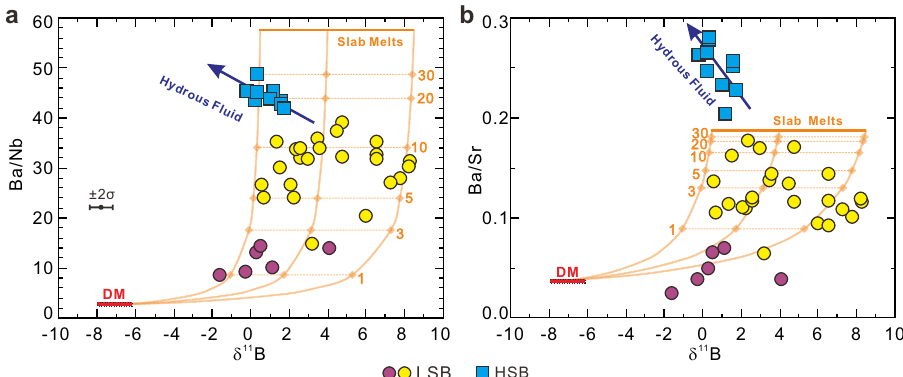
Fig. 5 Boron isotopes and trace element systematics of the Expedition 352 boninites compared to mixing trajectories between the calculated slab melt/ fl uid and the depleted mantle. Plots of a Ba/Nb and b Ba/Sr vs. δ 11 B for the International Ocean Discovery Program Expedition 352 boninites. Error bars (2 σ = 0.6 ‰ ) are for boninite δ 11 B. The mixing curves are between the depleted mid-ocean ridge basalt mantle (DM 32,49,64 ) and the calculated gabbroic protolith granulite melts. The numbers on the mixing curves represent the mass percentage of the slab melt. The δ 11 B of the gabbroic protolith granulite melts are assumed to be from + 0.5 ‰ to + 8.5 ‰ . LSB: low-silica boninite; HSB: high-silica